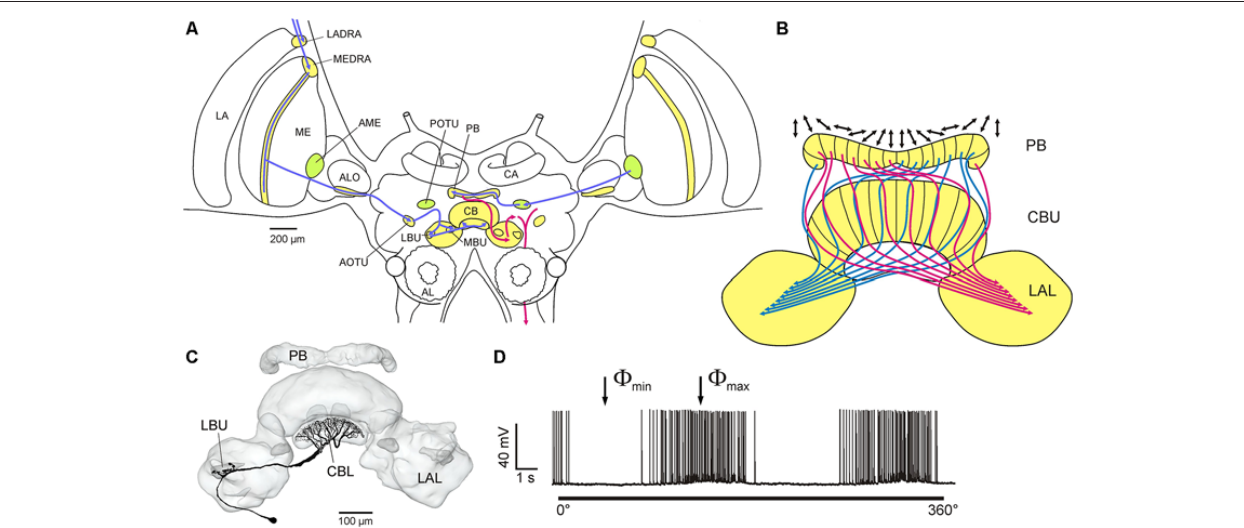
FIGURE 4 | Central processing of polarized light signals from zenithal directions in the locust brain. (A) Polarization vision pathways in the brain of the desert locust. Processing stages for polarization analysis include dorsal rim areas in the lamina and medulla (LADRA, MEDRA), a ventral layer in the anterior lobe of the lobula (ALO), the anterior optic tubercle (AOTU), the lateral and medial bulbs of the lateral complex (LBU, MBU), the central body (CB) and the protocerebral bridge (PB). In a second pathway, the accessory medulla (AME) is connected to the PB via the posterior optic tubercle (POTU). Inputs to the central complex are shown in blue, outputs in red. AL, antennal lobe; CA, calyx of the mushroom body. (B) Idealized compass-like representation of E -vector tunings (double arrows) in columnar neurons of the PB and upper division of the central body (CBU). LAL, lateral accessory lobe. (C,D) Morphology (C) and polarized light sensitivity (D) of a tangential neuron of the lower division of the central body (CBL). When the animal is illuminated from above through a rotating polarizer, spike frequency is modulated as a function of E -vector orientation. Maximum ( Φ max ) and minimum spiking activity ( Φ min ) occurs at orthogonal E -vectors. (A,B) adapted from Pfeiffer and Homberg (2014); (C,D) from Heinze et al. (2009) with kind